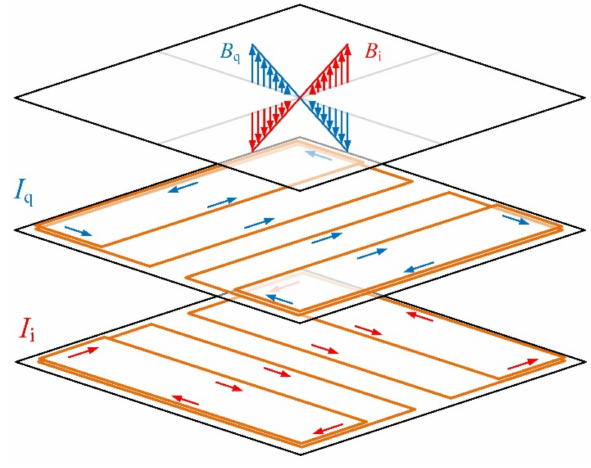
Figure 2. The layout of x - and y -gradient coils for constant gradient